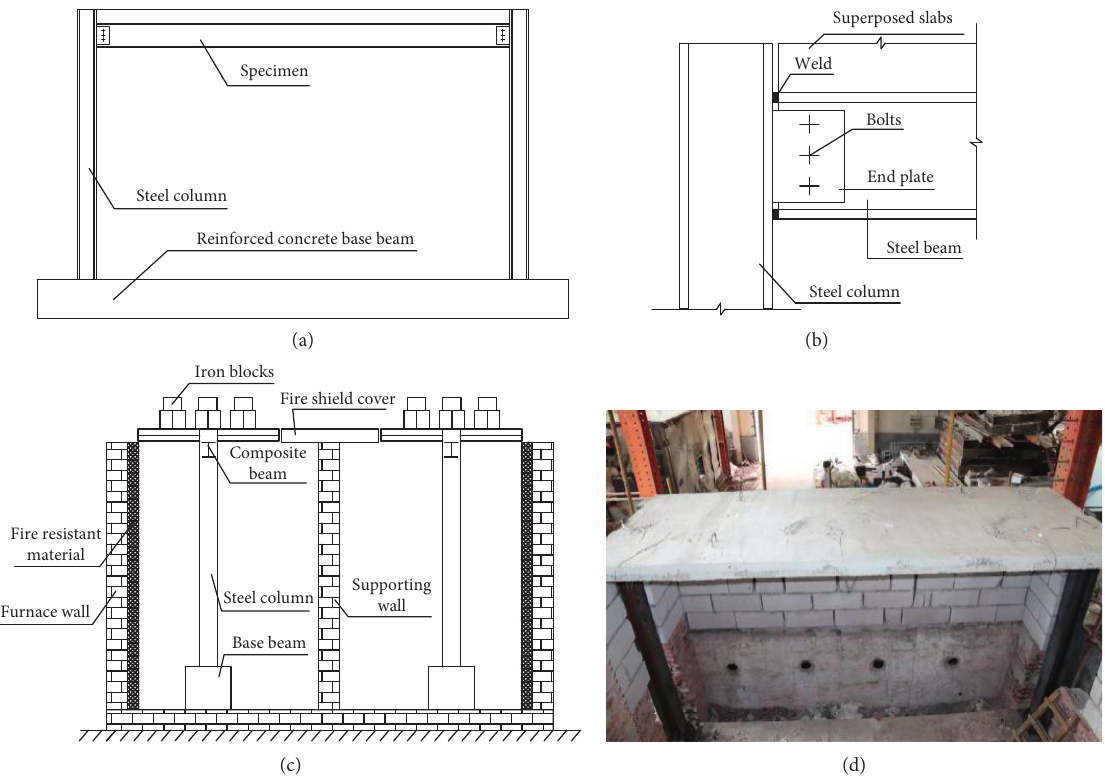
Figure 2: Experimental program: (a) specimen restraining scheme, (b) details of restraints, (c) test setup, and (d) composite beam specimen.